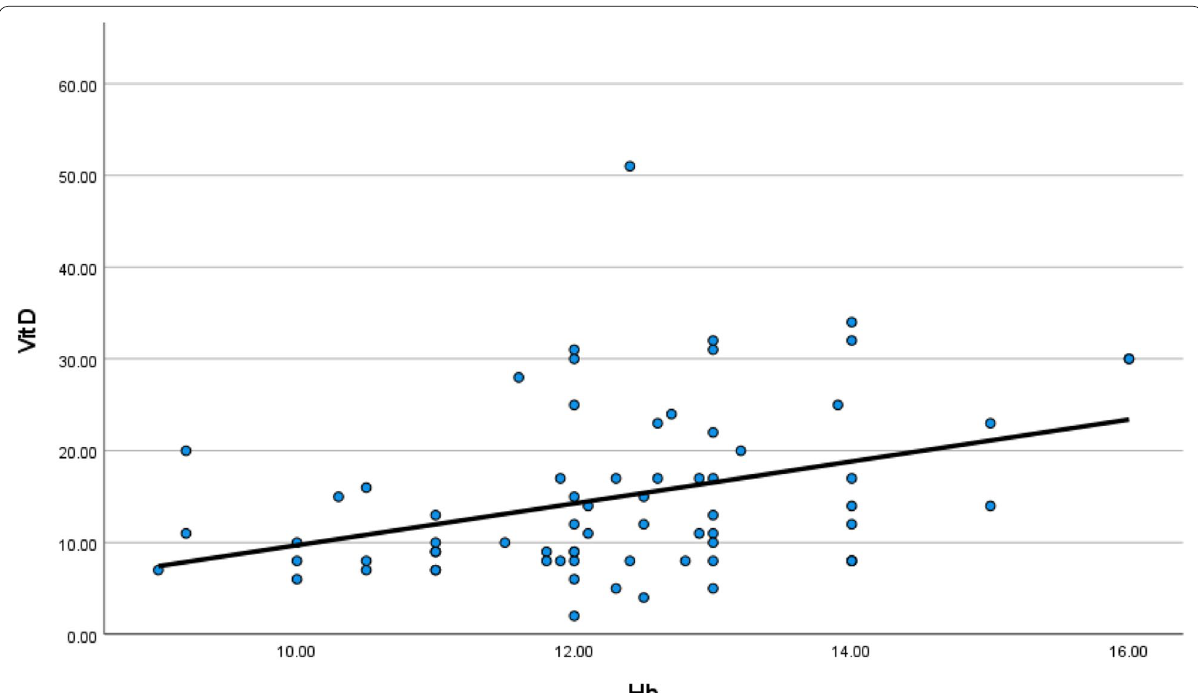
Fig. 21 Correlation between serum vitamin D and hemoglobin level in COVID 19 patients (symptomatic and